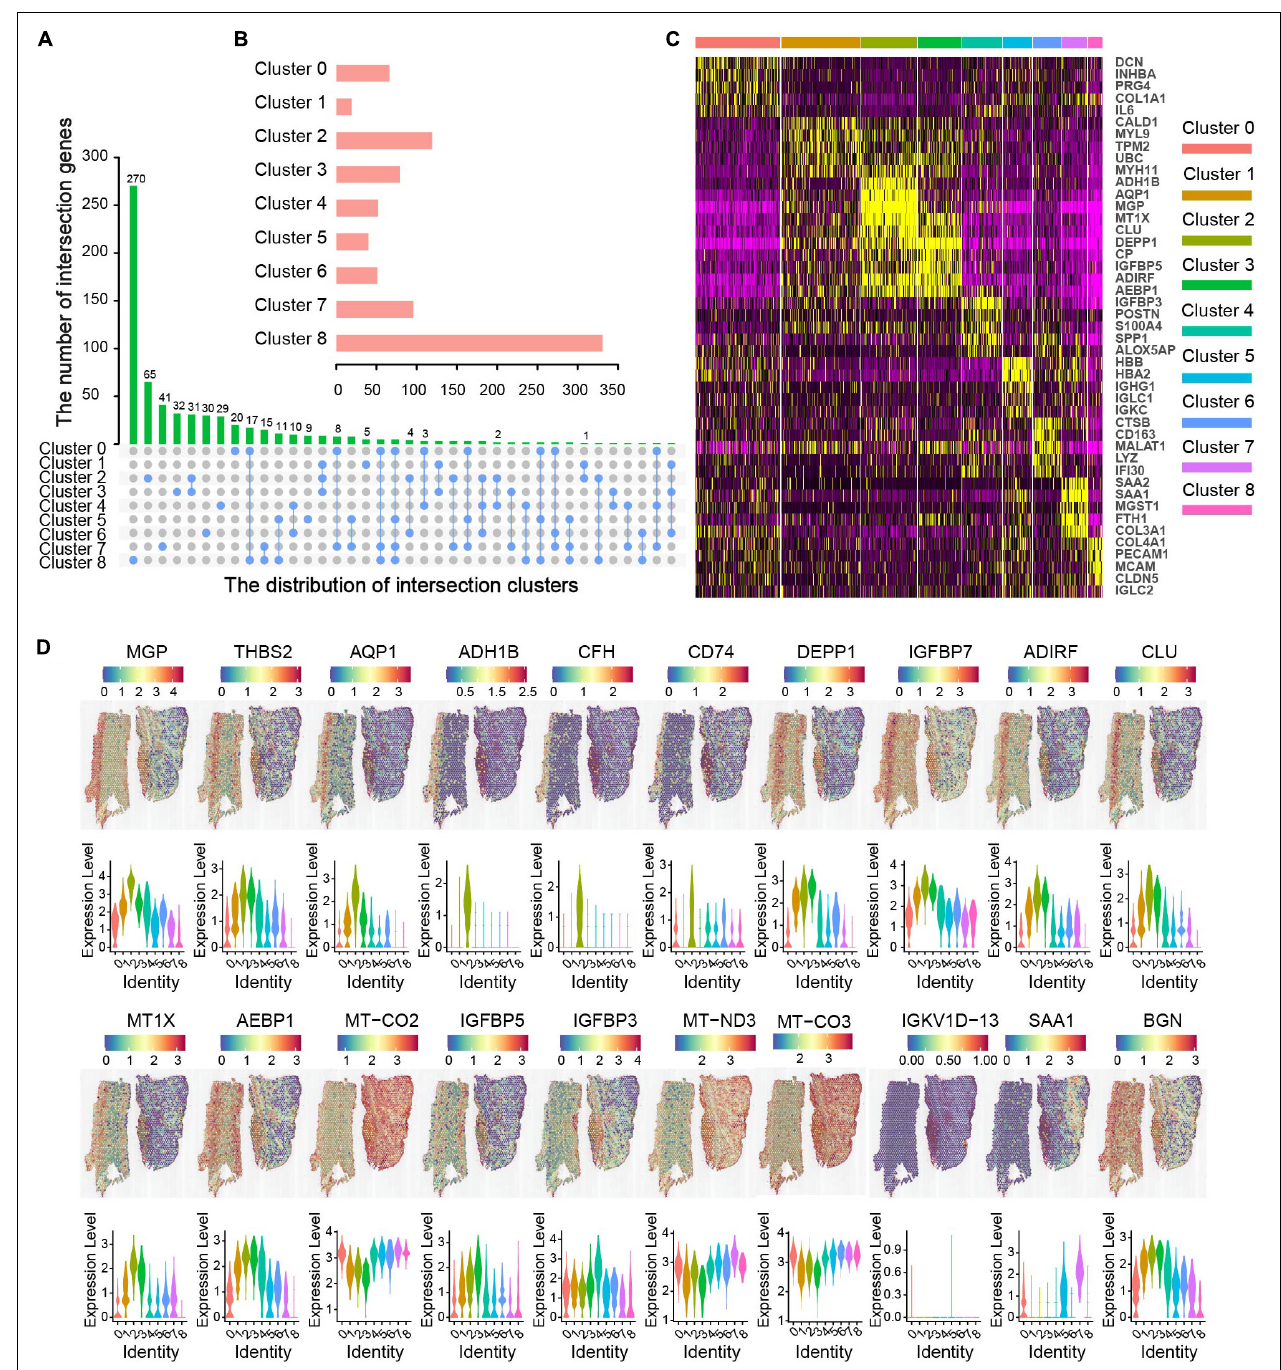
FIGURE 3 | Molecular characteristics related to spatial location in ascending aortic dissection tissue. (A) Correlation clusters of overlapping DEGs. The column length represents the number of overlapping genes. (B) The bar chart represents the number of genes in each cluster. (C) The heat map displays the top five (by average log [fold change]) genes in each cluster. The X -axis represents the distribution of intersection clusters; Y -axis represents the number of intersection genes. (D) The top 20 genes of location and expression level were in each layer. Violin plots of gene expression levels show different clusters with different